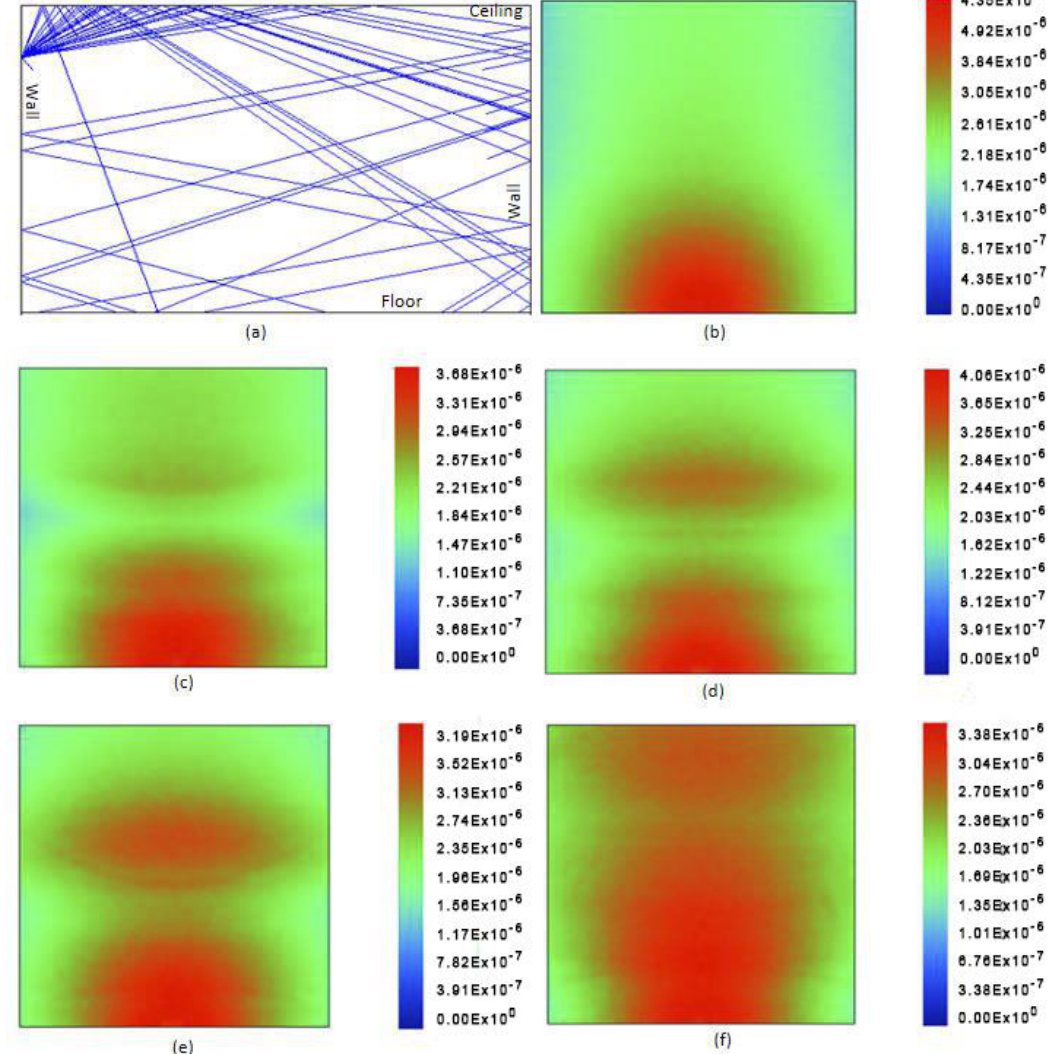
Figure 4. Light distribution on the floor with the setup ( a ) at distance of d = 40 cm of ( b ) no lens; ( c ) B1; ( d ) B2; ( e ) B3; ( f )